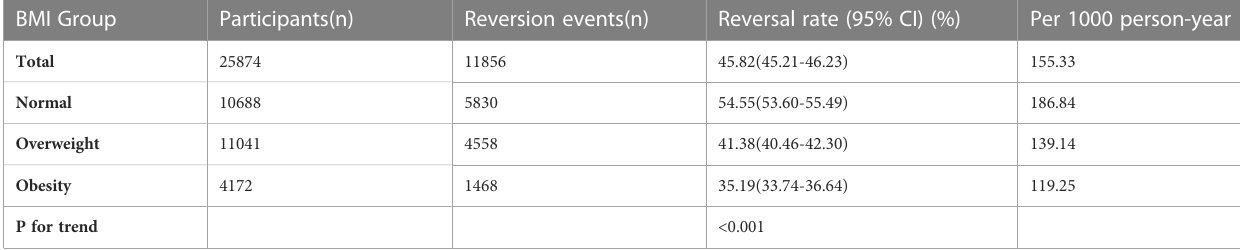
TABLE 2 The rate of reversion to normoglycemia in people with IFG (% or Per 1000